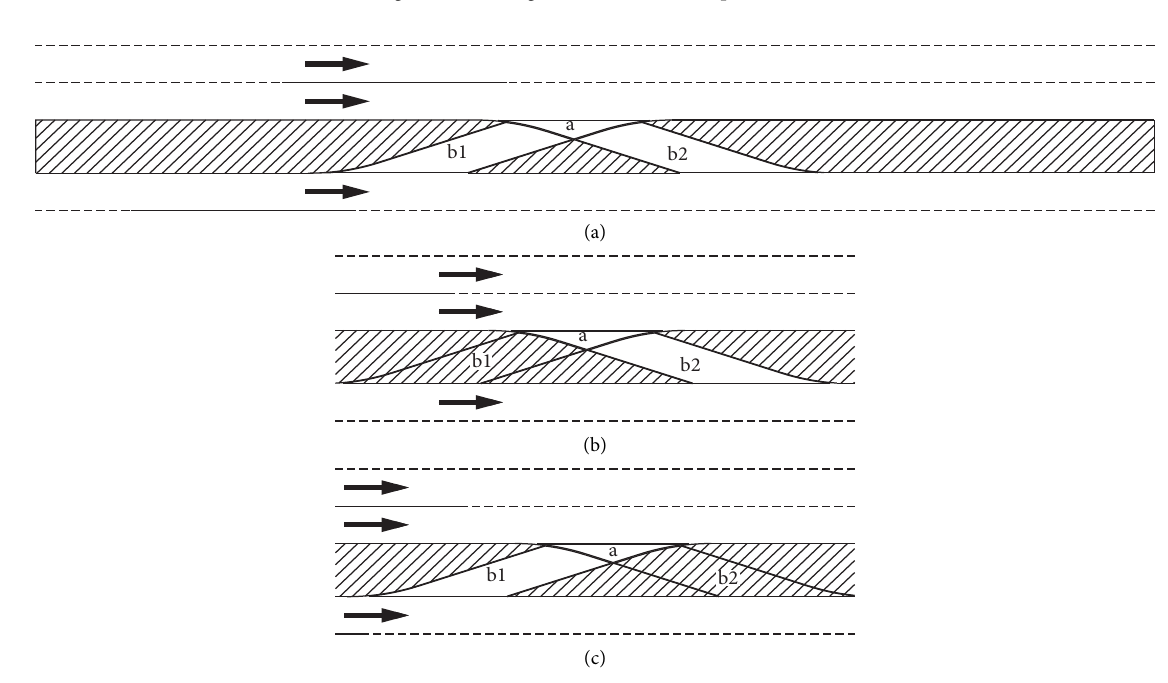
Figure 3: The geometric design of switchable ramp and two of its